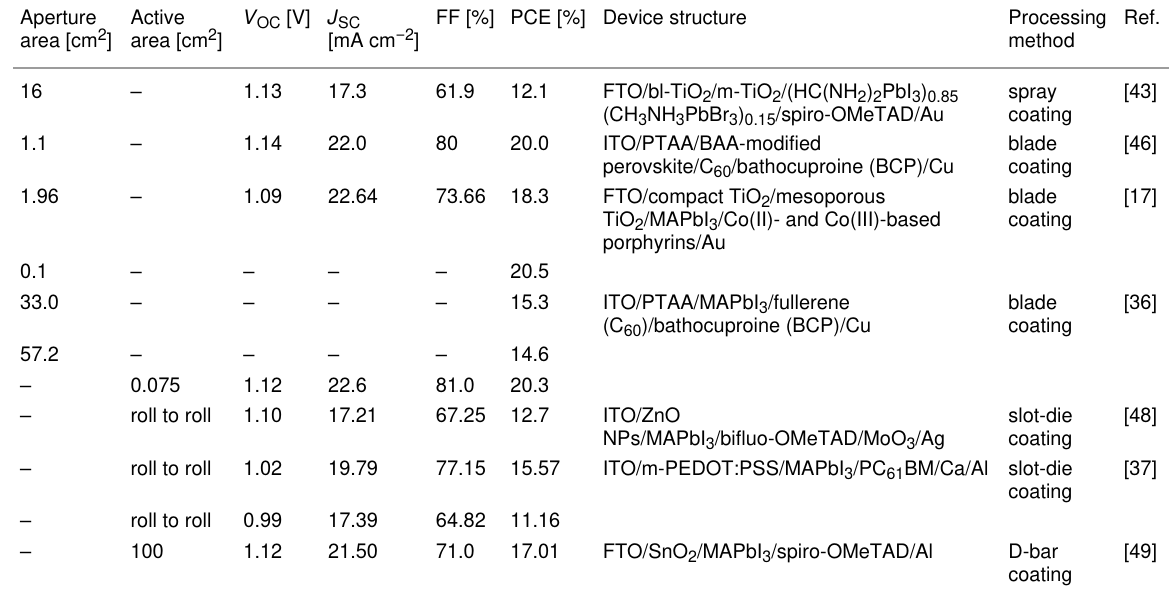
Table 1: Summary of relevant photovoltaic parameters of recently reported large-area